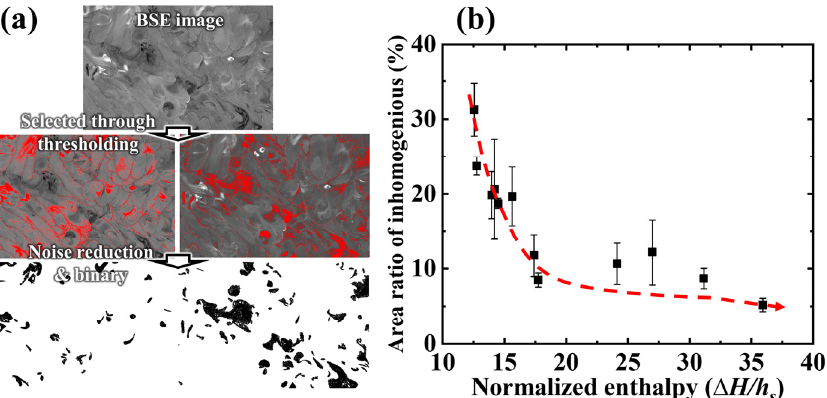
Figure 4. Quantitative characterization of composition inhomogeneity defects within the samples printed by different energy input: ( a ) schematic of measurement process, ( b ) statistical results.